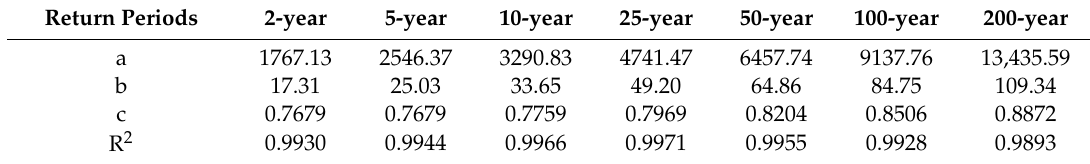
Table 1. The parameters used for di ff erent scenarios for the designed simulations.